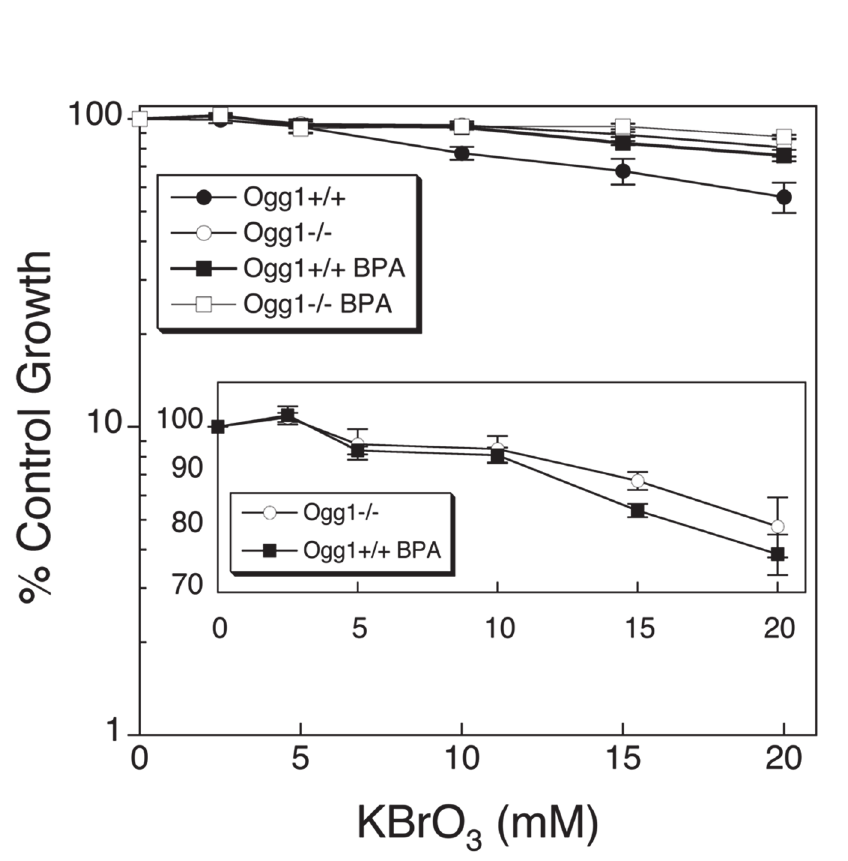
Fig 2. Lack of a BPA co-exposure protective effect in Ogg1-deficient cells. Ogg1-proficient and deficient cells were treated for 1 h with the oxidizing agent KBrO 3 with and without pre-treatment with 150 μ M BPA for 1 h prior to the induction of KBrO 3 -induced DNA damage and then for a total of 24 h (see Materials and Methods). Inset, comparison of Ogg1-proficient cells co-exposed to BPA and KBrO 3 and the Ogg1-deficient cell line exposed to KBrO 3